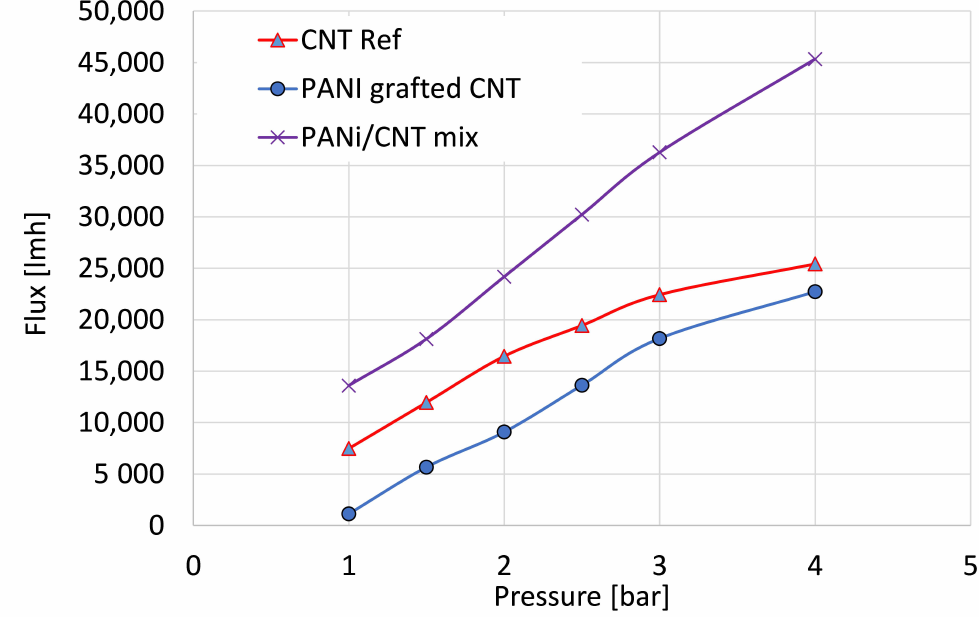
Figure 6. Distilled water flux properties of the reference CNT (triangle), PANI / CNT physical mixture (X), and PANI-coated CNT (circle)